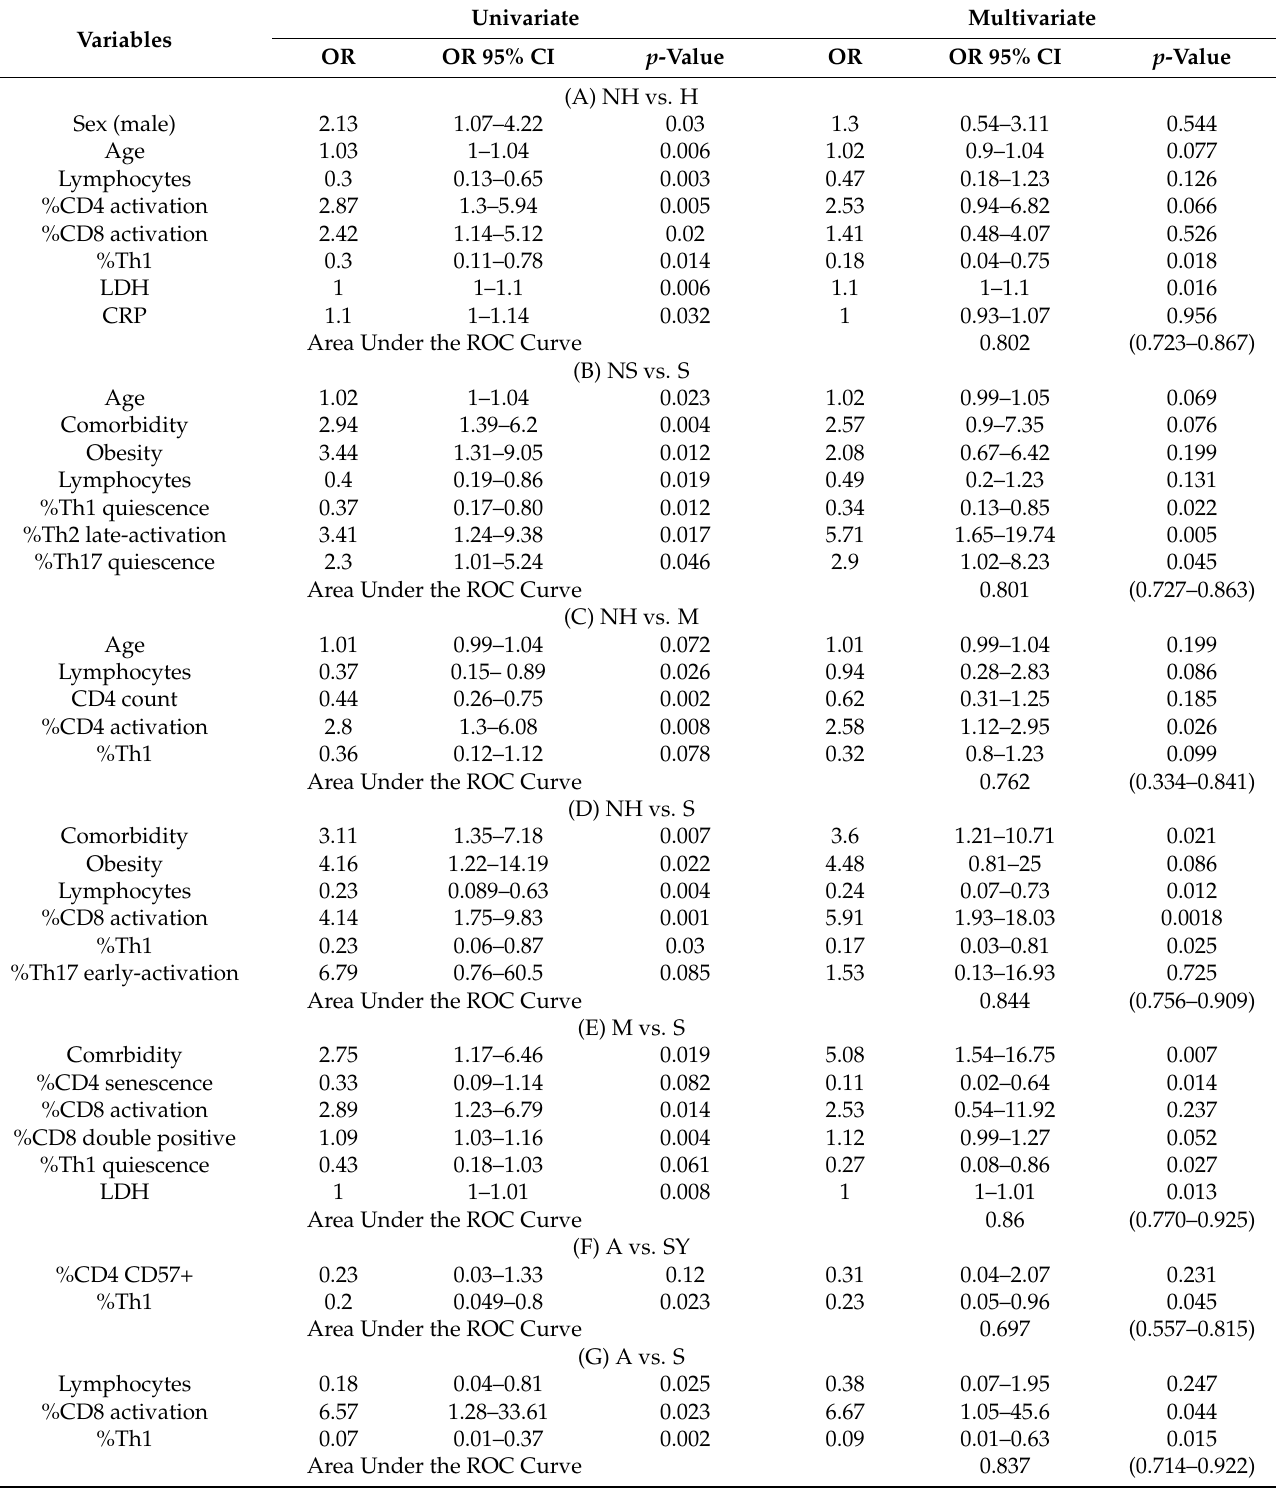
Table 4. Risk factors associated with hospitalization